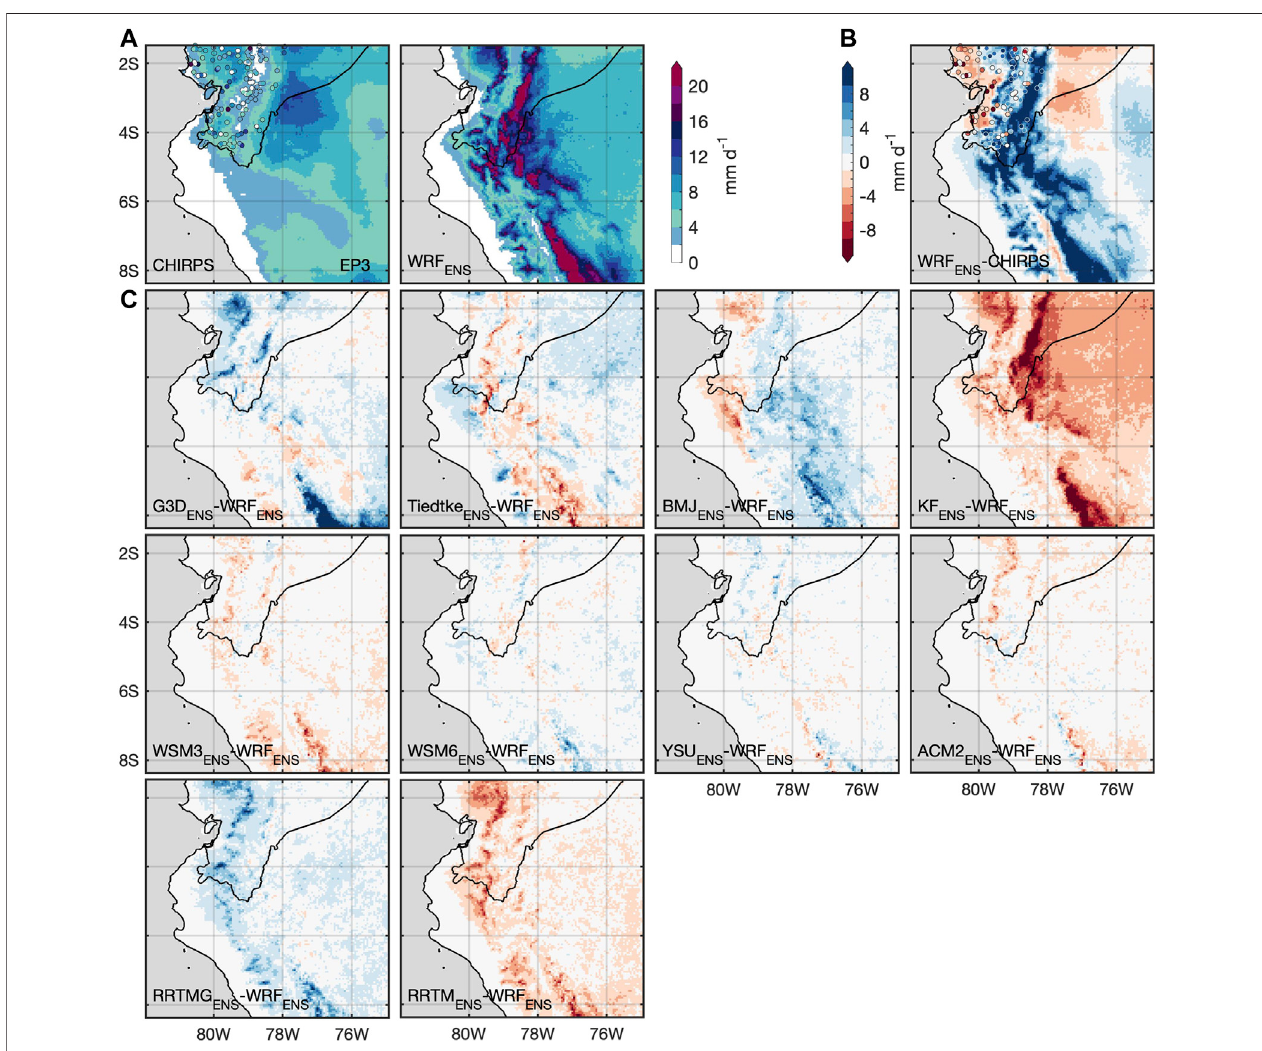
FIGURE 5 | As Figure 3 , but for EP3. Apart from CHIRPS, in (A) JFM mean precipitation values of and (B) WRF ENS bias against 132 INAMHI stations having less than 5% of missing values during JFM 2007 are shown.